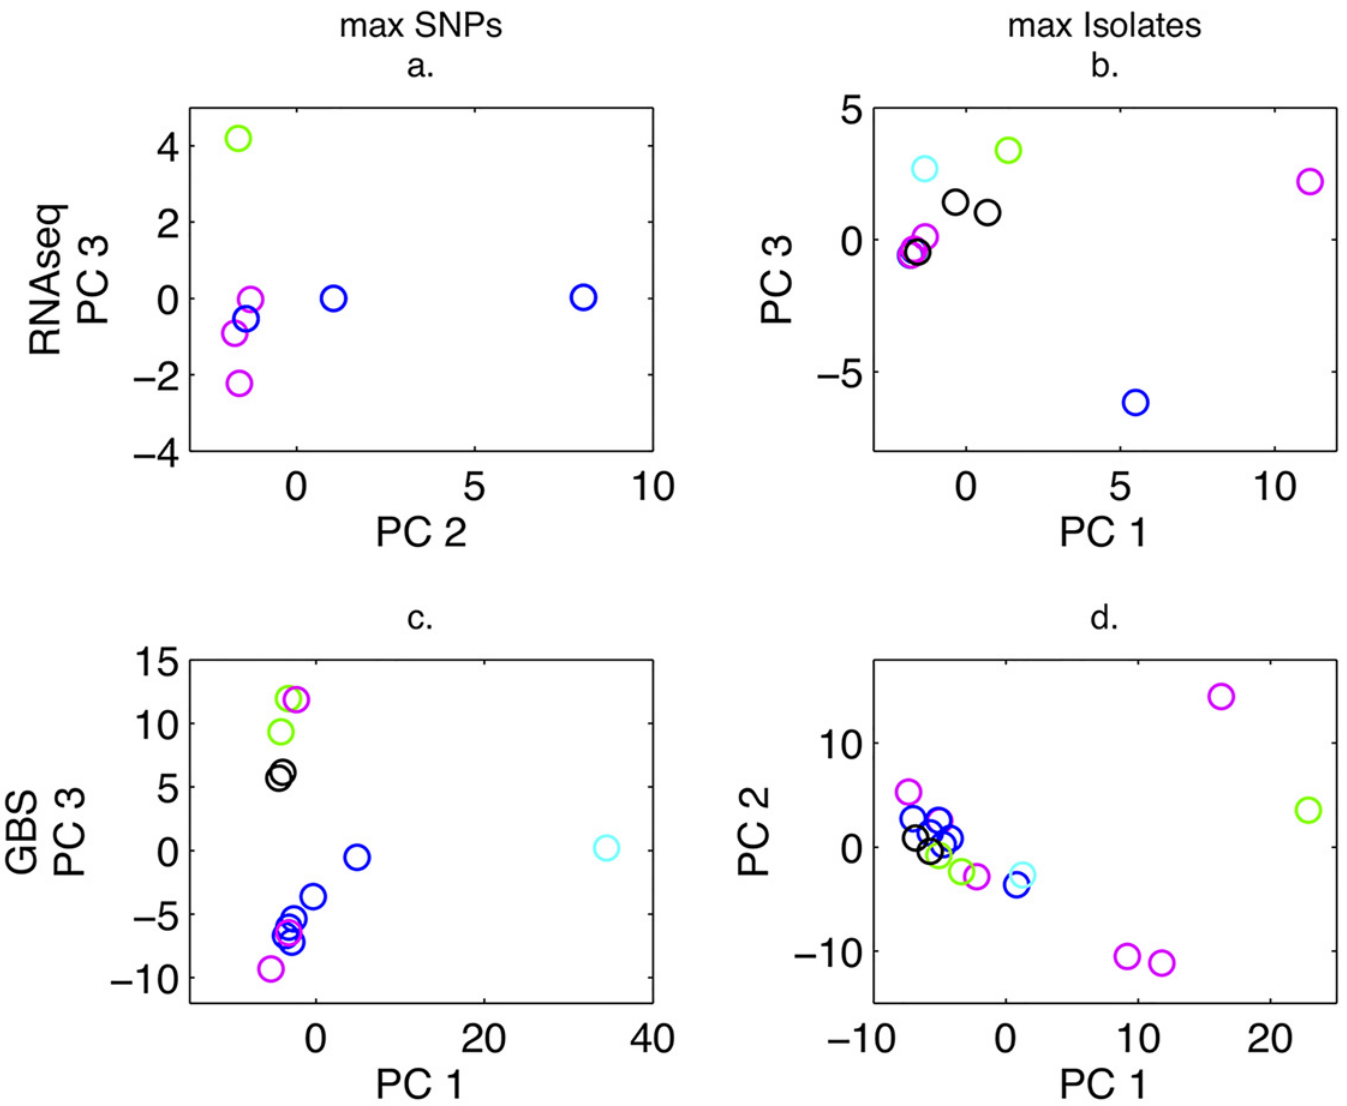
Fig 3. Principal components analysis of RNA-seq and GBS SNP data for P . humuli isolates, maximizing for SNPs or isolates retained. a. PCA using 1,290 biallelic SNPs for P . humuli isolates only. The green circle represents the 490 – 5 isolate from Japan. The blue circles (3) represent isolates from NY. The magenta circles (4) represent isolates from Oregon. b. PCA using 135 biallelic SNPs for P . humuli isolates only. The blue circles (4) represent isolates from NY. The magenta circles (6) represent isolates from Oregon and Washington. The black circles (3) represent isolates from Vermont. The green circles (2) represent isolates from Japan. The cyan circle represents an isolate from Wisconsin. c. PCA using 11,922 biallelic SNPs for P . humuli isolates only. The magenta circles (3) represent isolates from OR and WA. The blue circles (6) represent isolates from NY. The black circles (2) represent isolates from VT. The cyan circle represents an isolate from WI. The green circles (2) represent isolates from Japan. d. PCA using 5,044 biallelic SNPs for P . humuli isolates only. The magenta circles (6) represent isolates from OR and WA. The blue circles (6) represent isolates from NY. The black circles (2) represent isolates from VT. The green circles (3) represent isolates from Japan. The cyan circle represents an isolate from